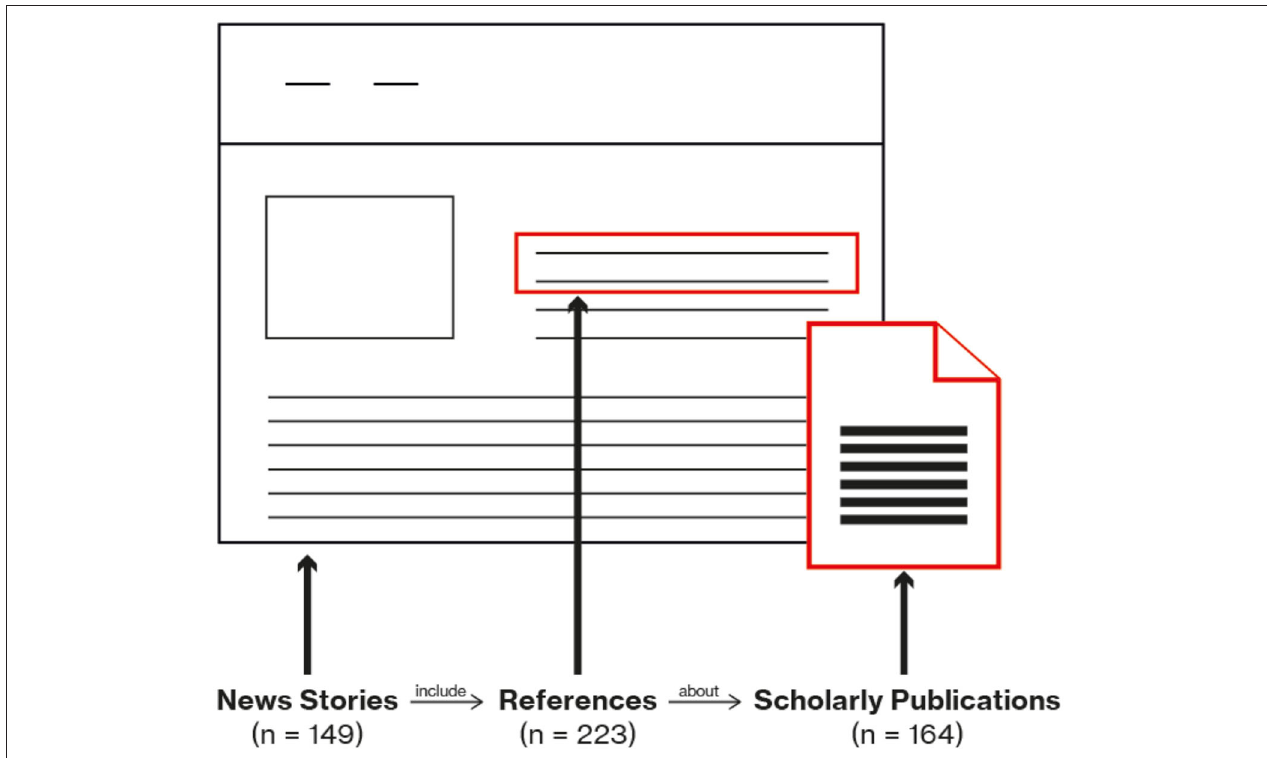
FIGURE 1 | Sample size and conceptualization of studies, references, and stories. In this study, we define “studies” as scholarly publications referenced in news stories; “stories” as news articles that implicitly or explicitly refer to research studies; “references” as those parts of the news story that relate to the research